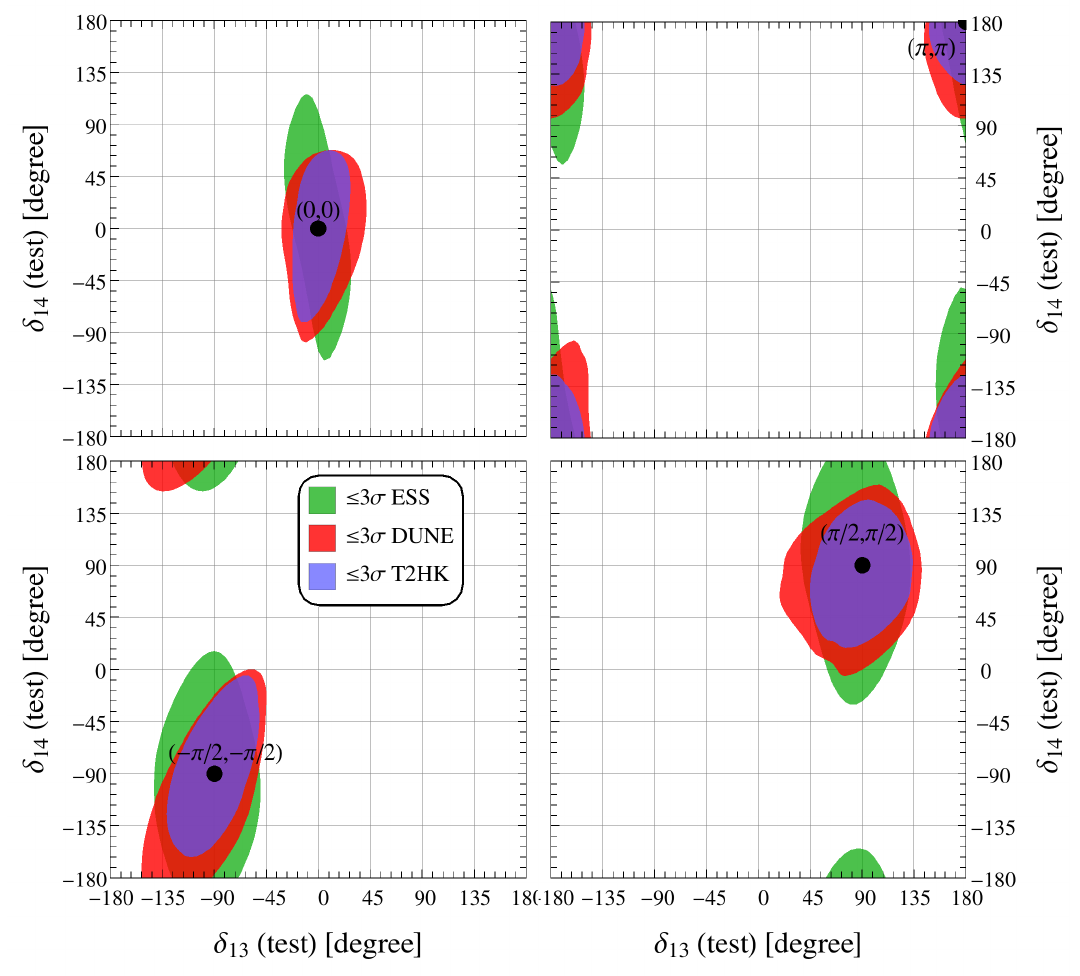
Figure 6. Reconstructed regions for the two CP phases δ 13 and δ 14 for the four representative couples of their true values indicated in each panel. Results are displayed for the three different experiments: ESS ν SB, DUNE, and T2HK. The NH has been fixed as the true and test hierarchy. The regions are drawn for the 3 σ (1 d.o.f.) confidence level. Figure taken from